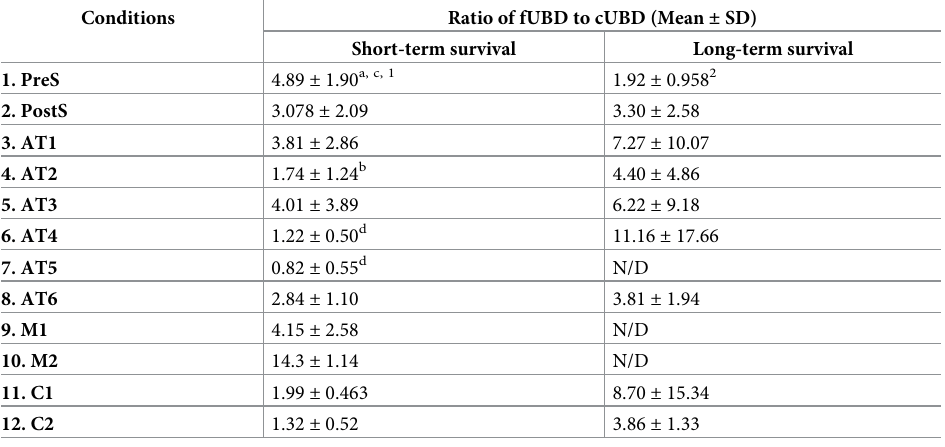
Table 3. Ratios of free ubiquitin D (fUBD) to conjugated ubiquitin D (cUBD) in patients with short-term survival ( < 12 m after surgery) and long-term survival ( > 12 m after surgery) at different time points.